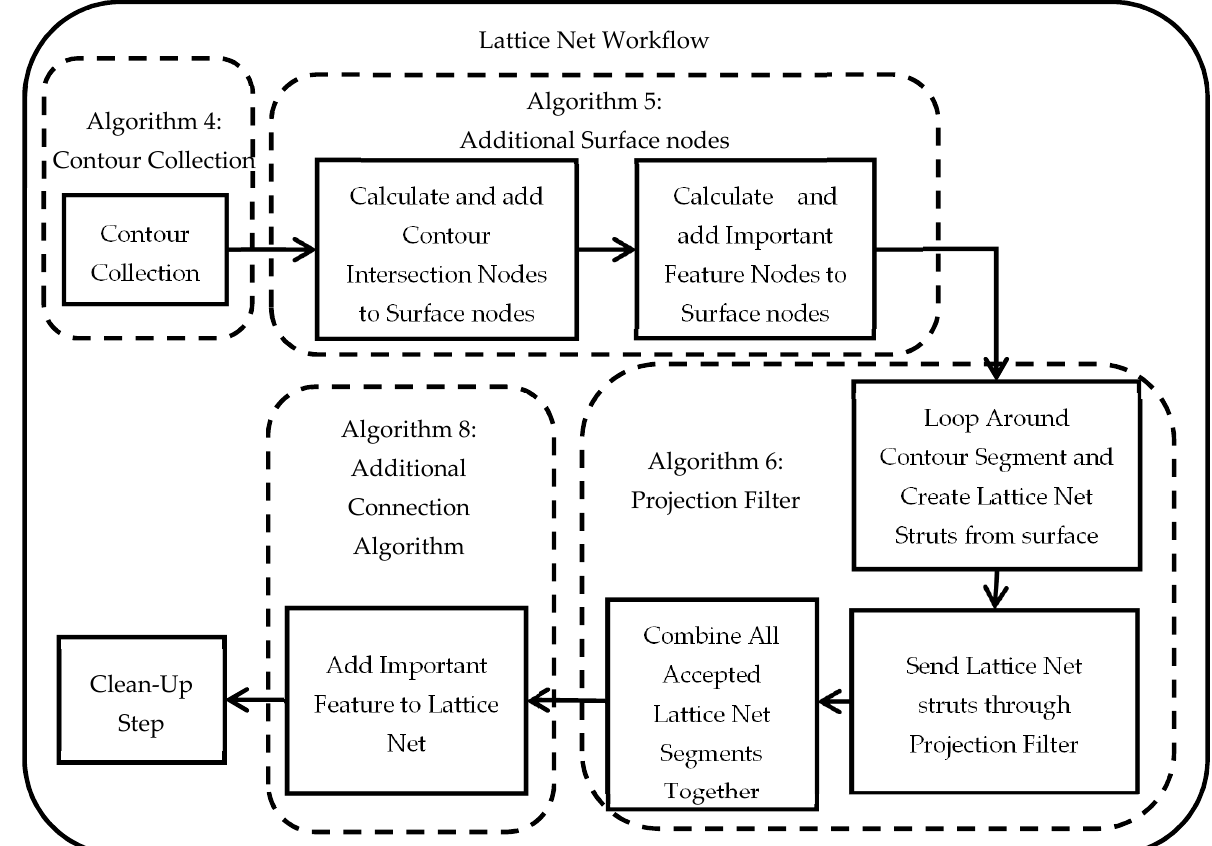
Figure 7. Lattice net